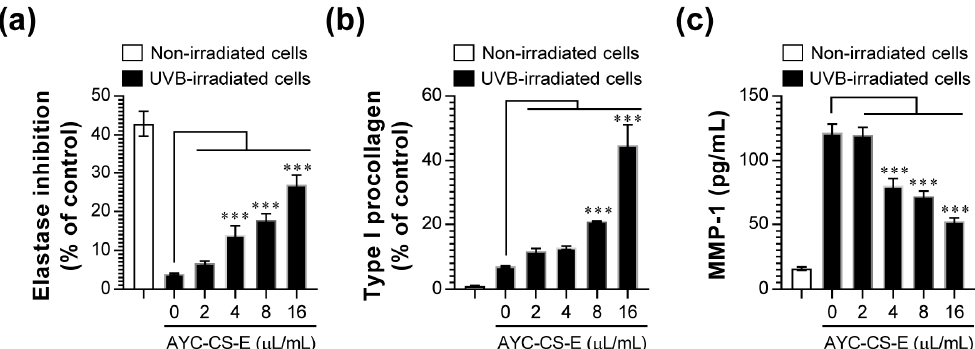
Figure 2. Effect of AYC-CS-E treatment on cell viability of non- and ultraviolet B (UVB)-irradiated human keratinocytes (HaCaT cells). ( a ) The HaCaT cell line at a concentration of 1 × 10 5 cells/well was seeded in a 48-well plate, incubated for 12 h in an incubator at 37 ◦ C and 5% CO 2 , and treated with the indicated concentrations (2, 8, 16, or 32 µ L/mL) of AYC-CS-E (30 mg/mL) for 24 h. The cell viability was measured using 3-(4, 5-dimethylthiazol-2-yl)-2, 5-diphenyl-tetrazolium bromide (MTT) assay. Con: non-treated HaCaT cells, ( b ) The cells (1 × 10 5 cells/well in 48-well plate) were treated with various concentrations (0.125 to 64 µ L/mL) of AYC-CS-E for 24 h after being exposed to 8 mJ/cm 2 UVB irradiation, as described in the Materials and Methods section. The cell viability for each condition was measured using the MTT assay. All bar graphs show the means ± standard deviation (SD) of 3 samples. One representative plot out of three independent experiments is shown. ** p < 0.01, and *** p < 0.001.